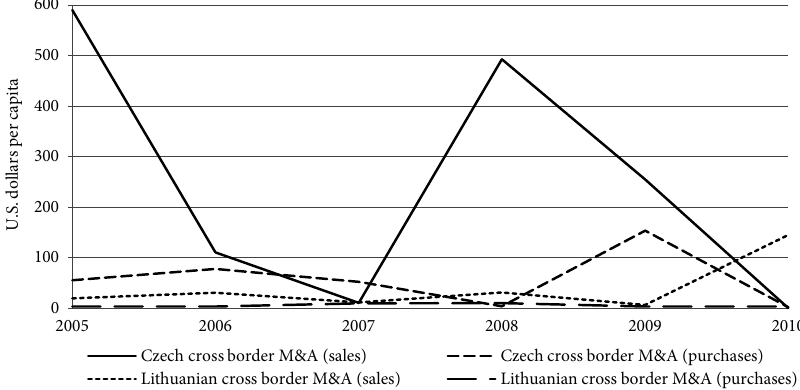
Fig. 1. Development of M&A in the Czech Republic and Lithuania in the period